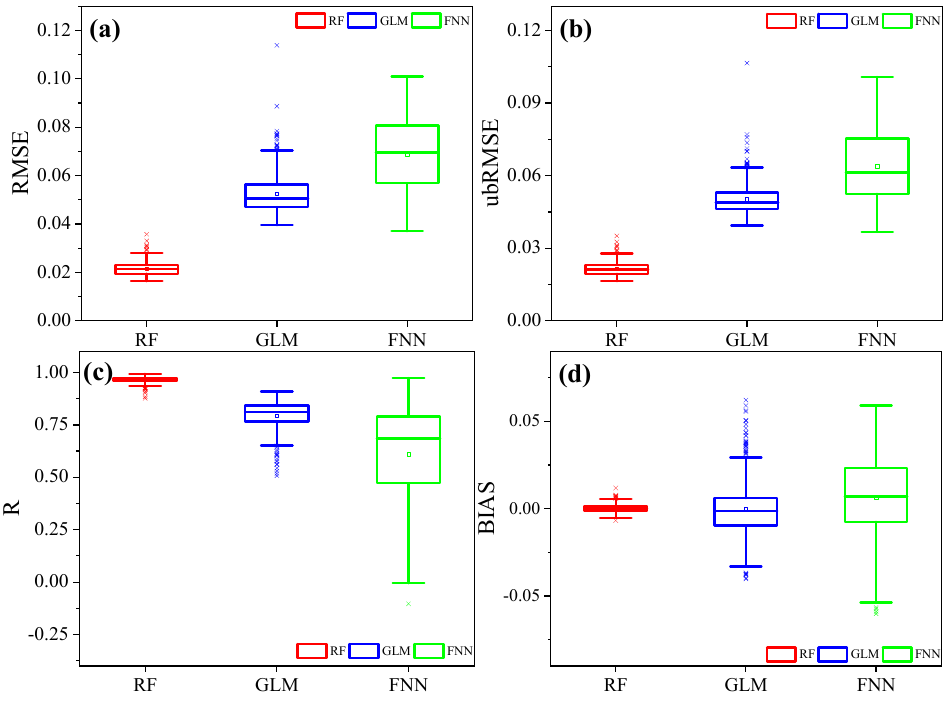
Figure 4. Boxplots of ( a ) RMSE in cm 3 /cm 3 , ( b ) ubRMSE in cm 3 /cm 3 , ( c ) correlation coefficient R, and ( d ) BIAS in cm 3 /cm 3 between simulated SM and original ESA CCI SM during the whole study period.